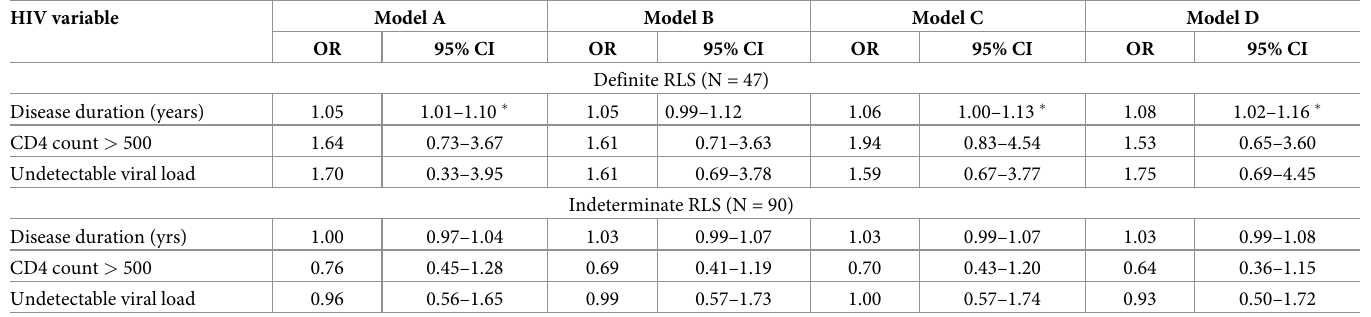
Table 3. Multinomial models of HIV specific predictors of RLS status in men with